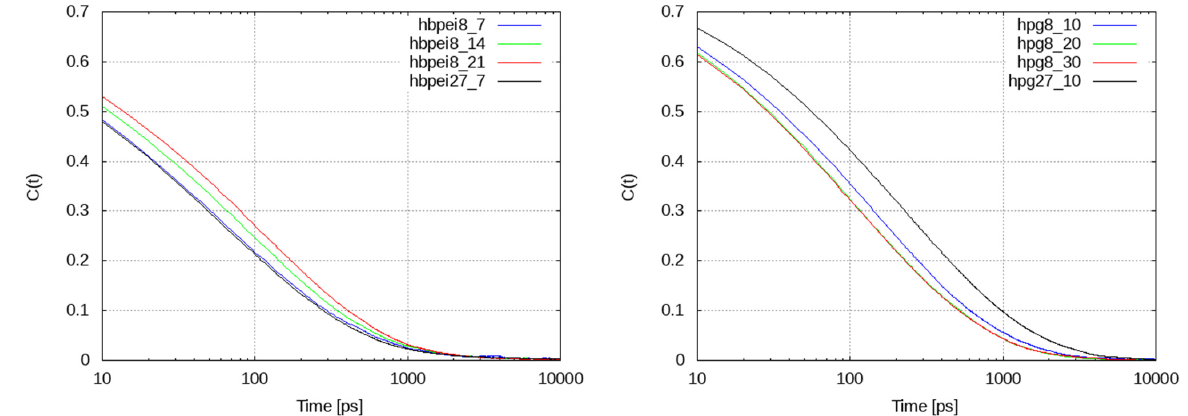
Figure 11. Hydrogen bond autocorrelation functions of HBPEI ( left )- and HPG ( right )-containing systems as a function of the carvacrol concentration and system size.